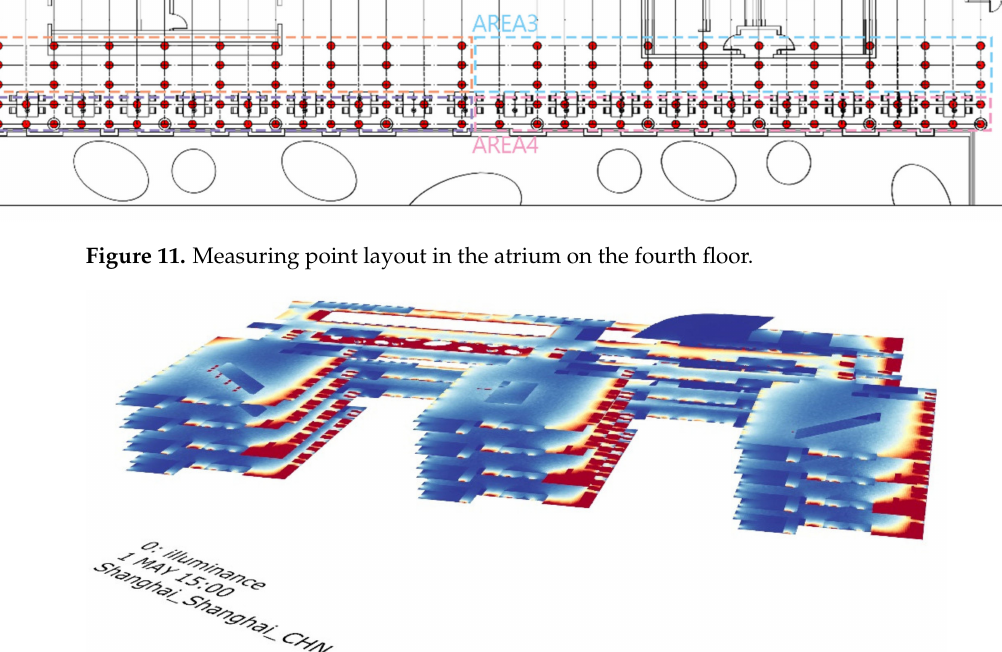
Figure 12. Illuminance simulation result.